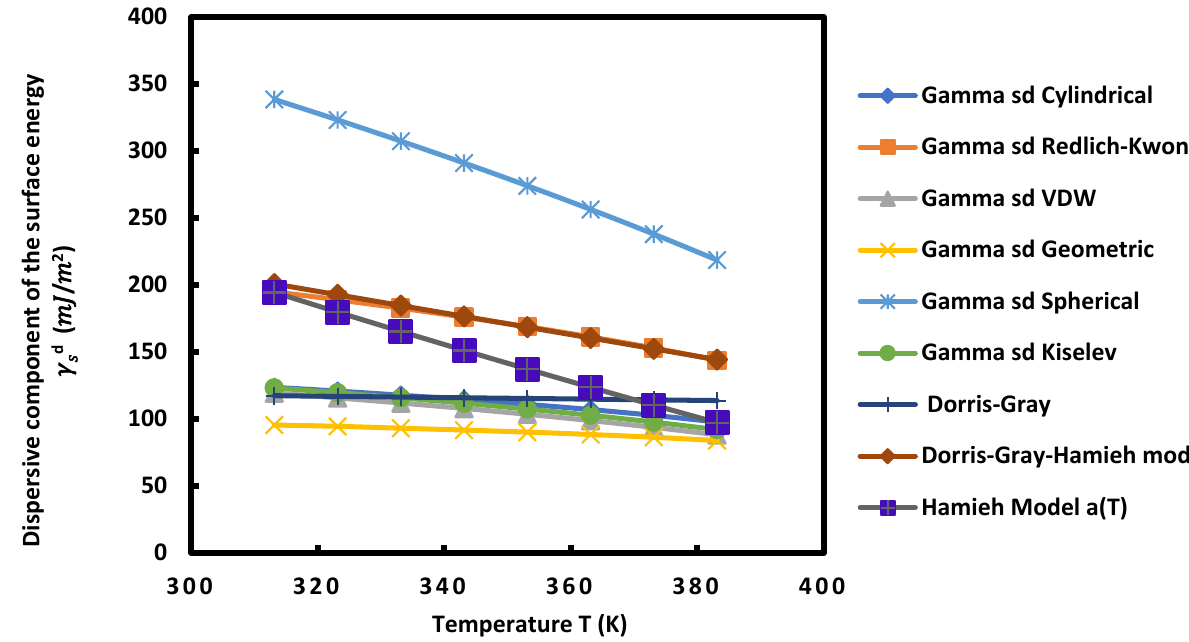
(cid:0) (cid:1) mJ/m 2 of UiO-66(NH 2 )